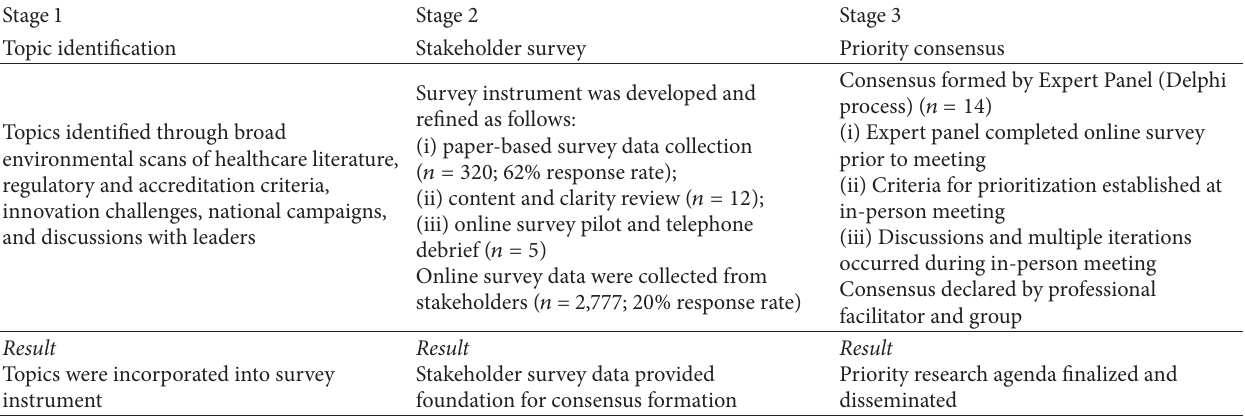
Table 1: Three-stage process for establishing consensus on research